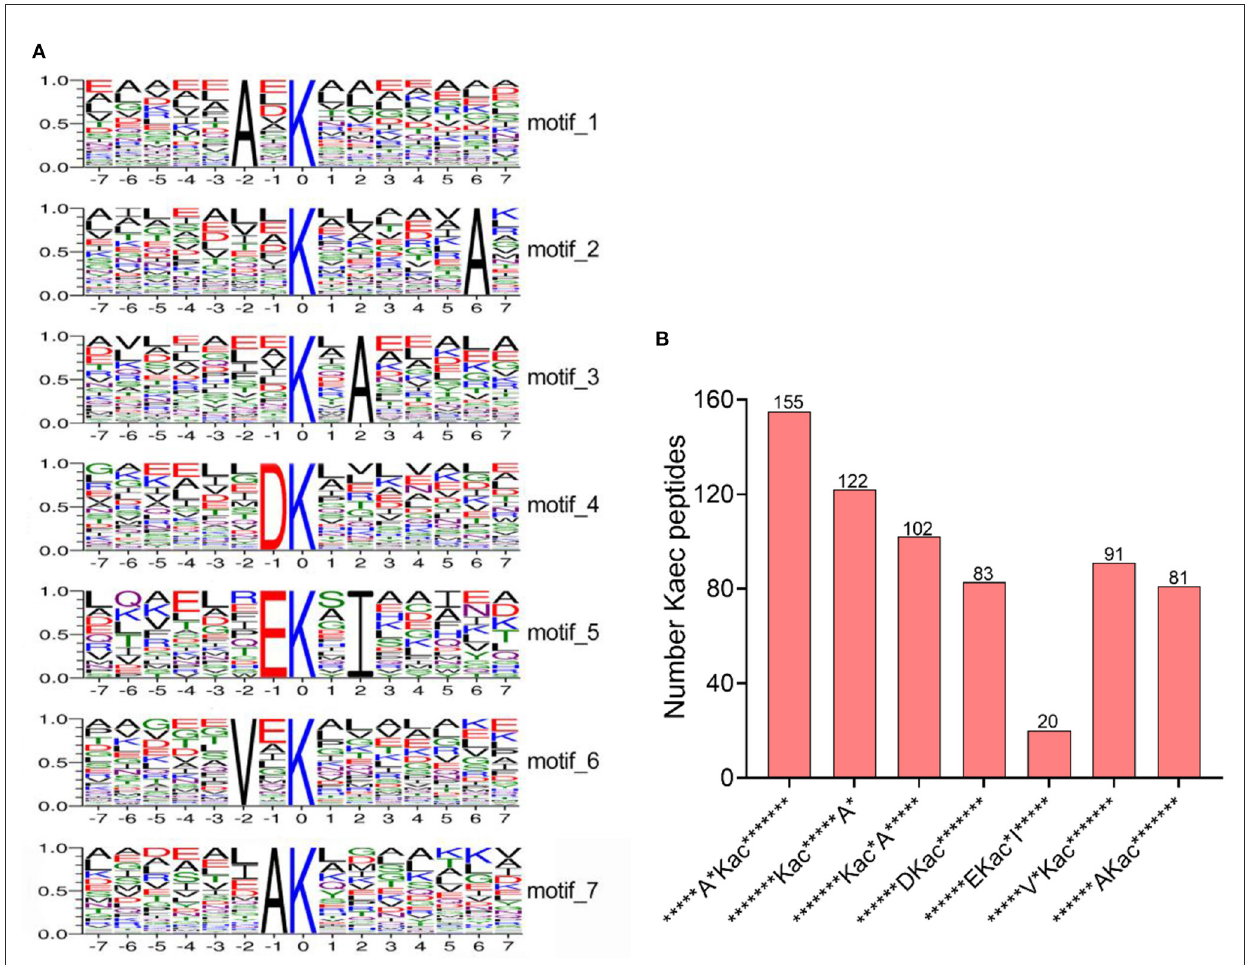
FIGURE2 Analysis of motifs of lysine acetylated-peptides under bile salt stress in V. alginolyticus . (A) The sequence logos of the acetylation motifs identified by MoMo software. These motifs consist of 14 residues (seven amino acids upstream and seven amino acids downstream) surrounding the acetylated lysine, and (B) Number of acetylated peptides contained in the identified